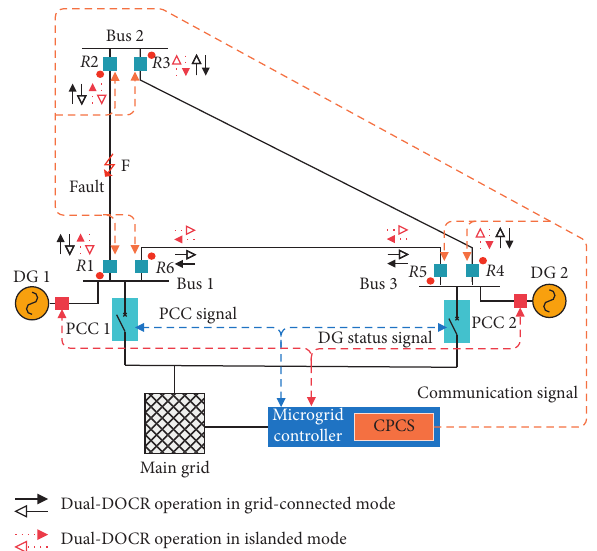
Figure 6: Structure of the centralized protection system control.